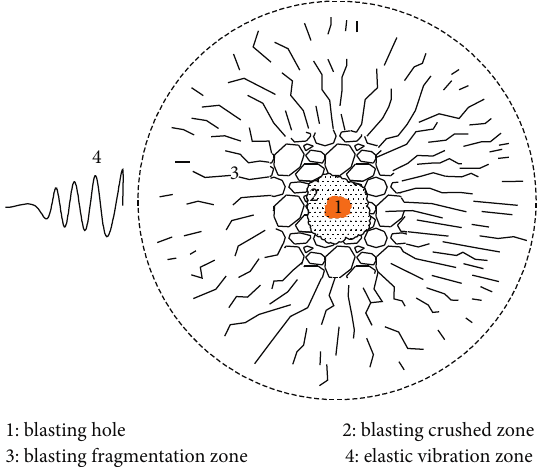
Figure 7: Sketch diagram of drilled hole blasting.